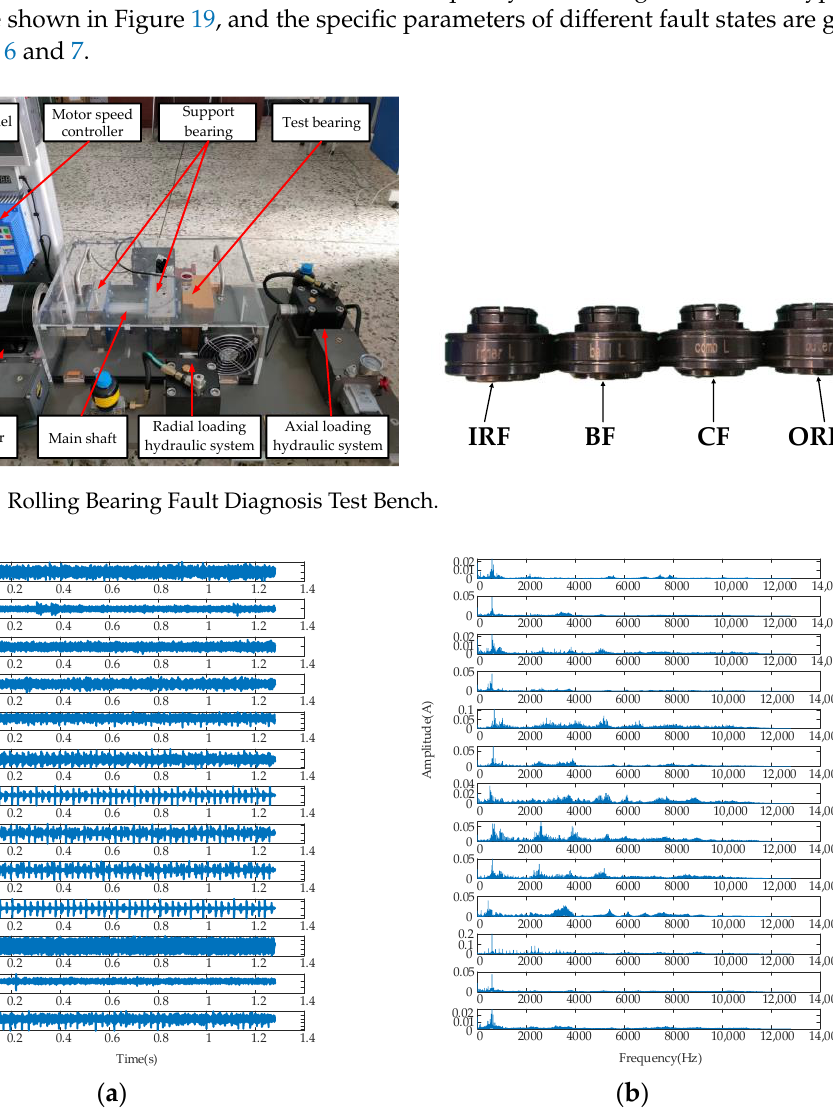
Figure 19. Time − frequency domain waveforms of rolling bearing under 13 kinds of work conditions. ( a ) Time domain waveforms under 13 conditions; ( b ) spectrums under 13 conditions. Table 6. ER-16K bearing parameters and failure frequency.